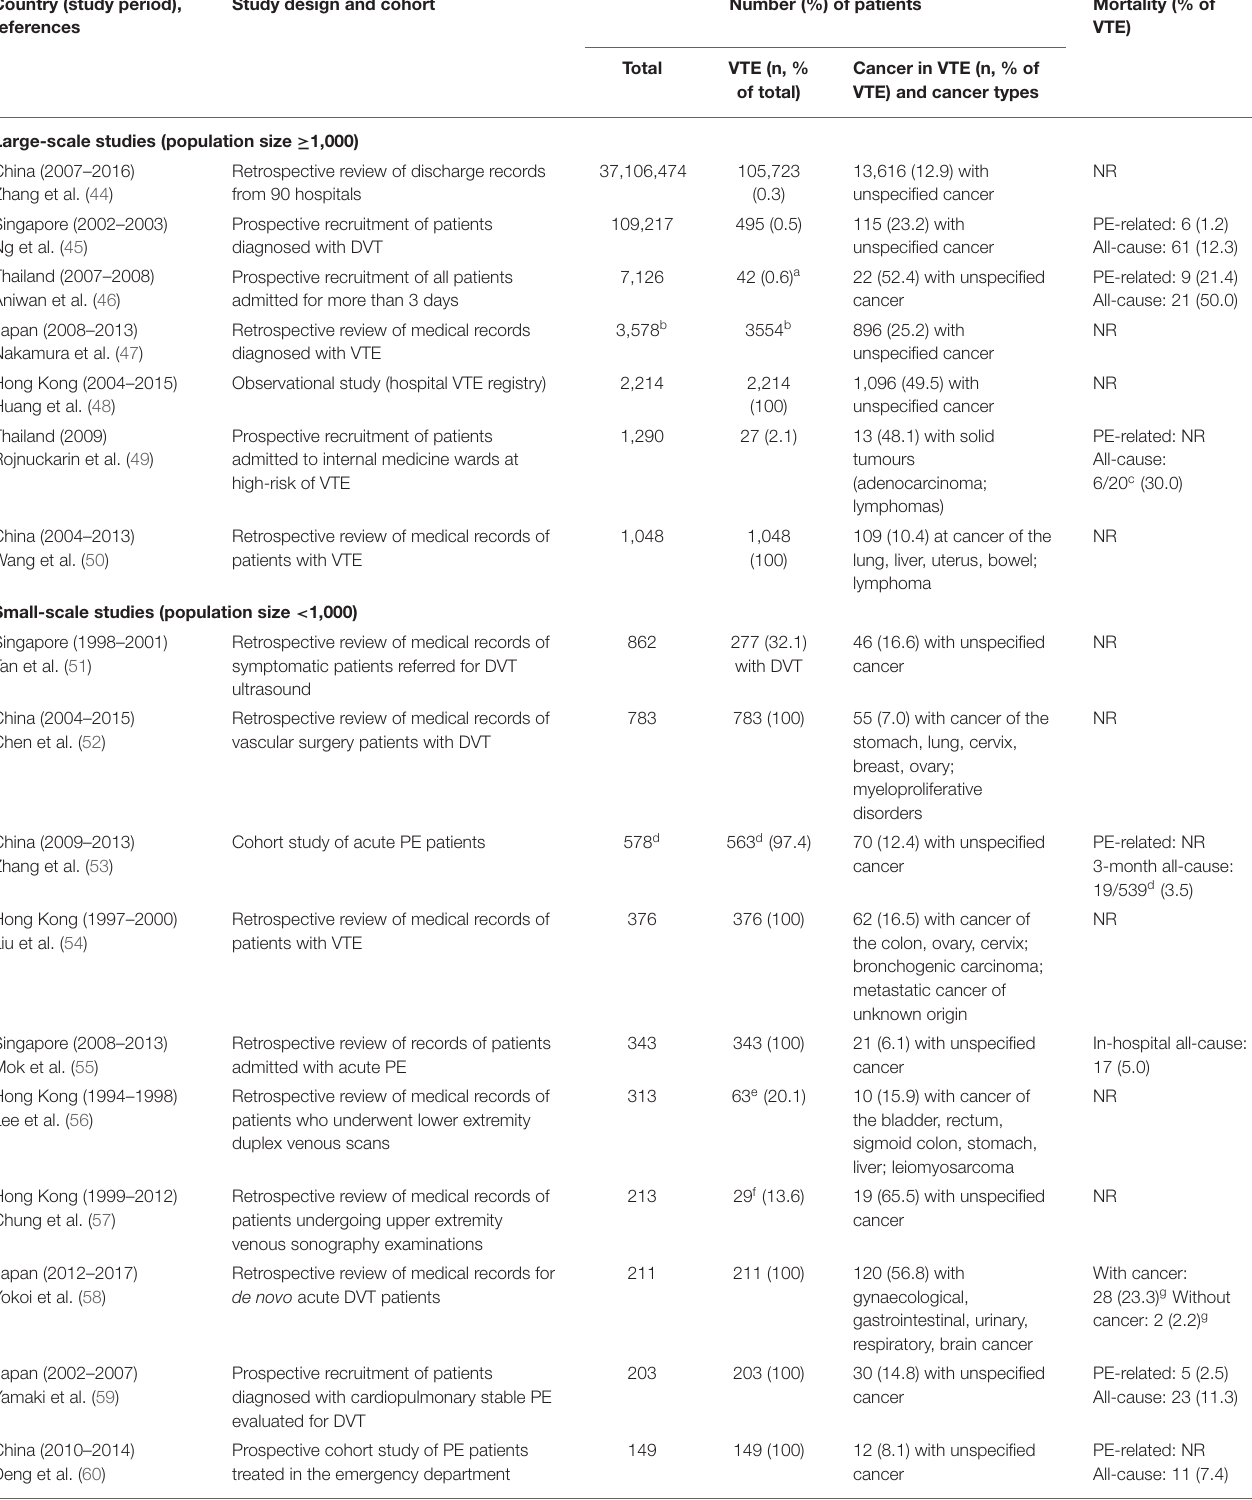
TABLE 2 | Cancer rates in studies involving VTE